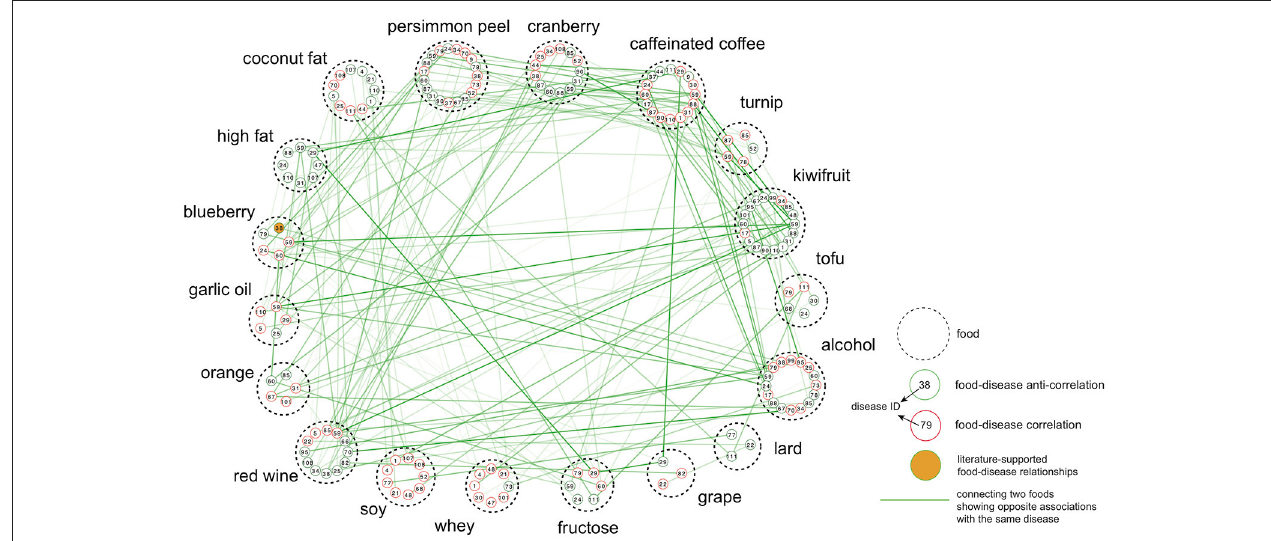
FIGURE 3 | Food-centric diet-disease network. Each node is a disease associated with the food represented by dashed circle. The number inside each node is the disease ID also used in Figure 2 . Only associations with absolute enrichment score values > 0.13 were selected for visualization. Nodes are connected if two foods show opposite associations toward the same disease, and the edge thickness is proportional to the difference between two enrichment